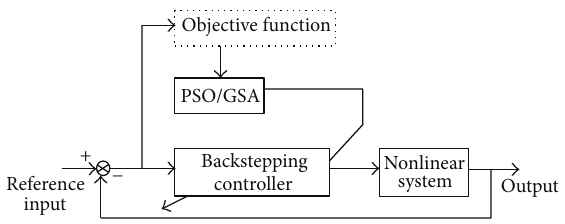
Figure 1: Block diagram of the proposed backstepping controller with PSO/GSA